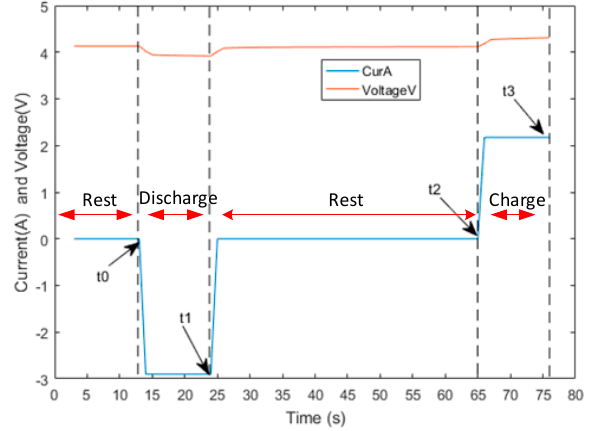
Figure 9. Battery cell charge-discharge states and time points for resistance calculation.